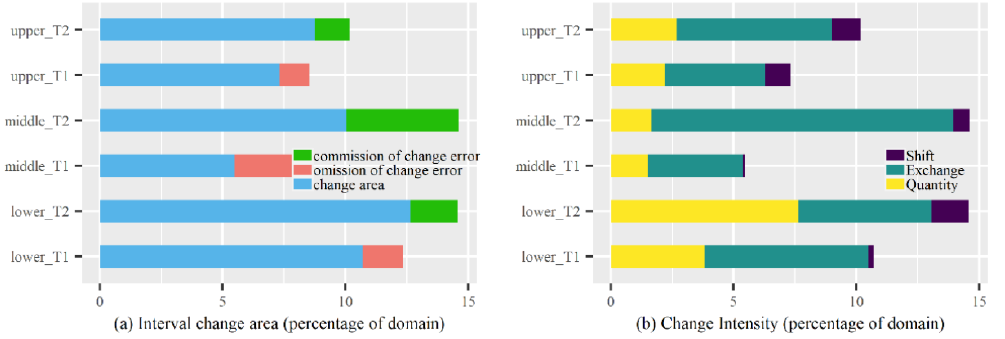
Figure 3. Size of interval level changes for the upper, middle, and lower reaches during the two time intervals (T1: 2000–2010, T2: 2010–2020). ( a ) Interval change area along with the hypothetical errors; ( b ) interval change component in terms of intensity.